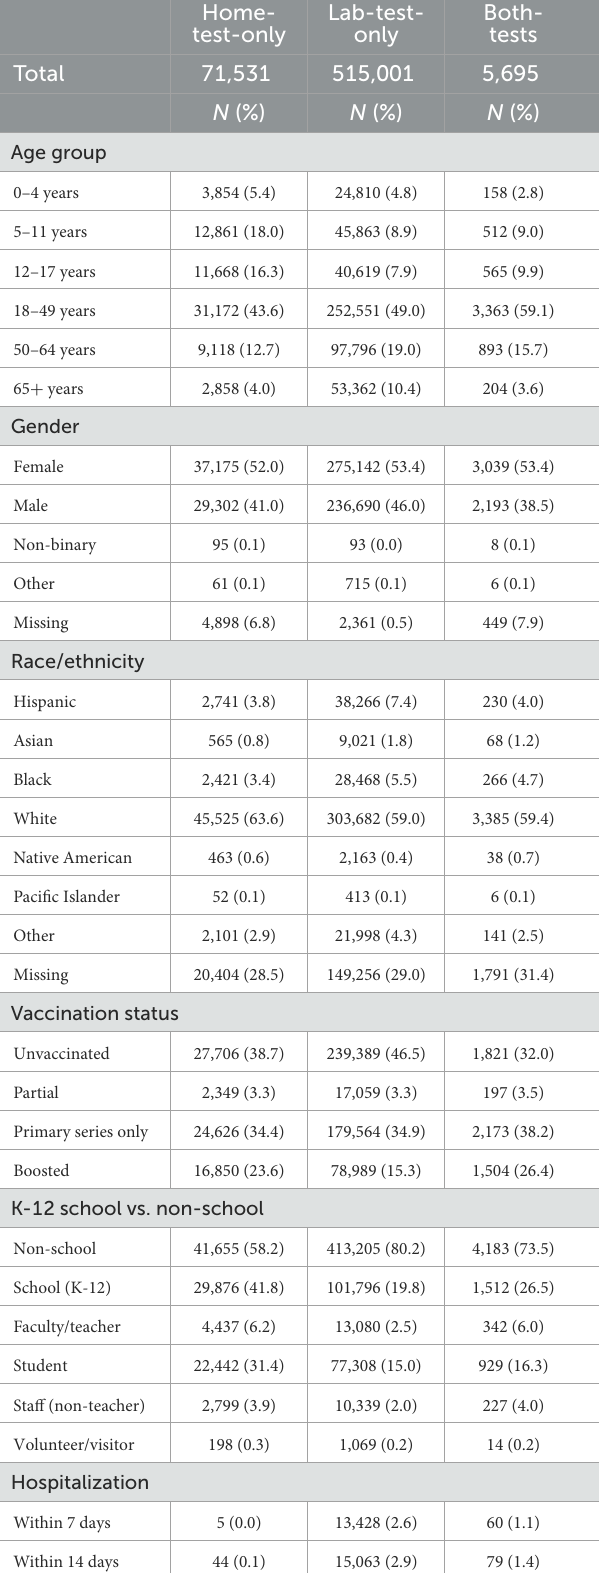
TABLE 2 Profile of the laboratory-test-only group, the home-test-only group, and the both-tests group. Home-